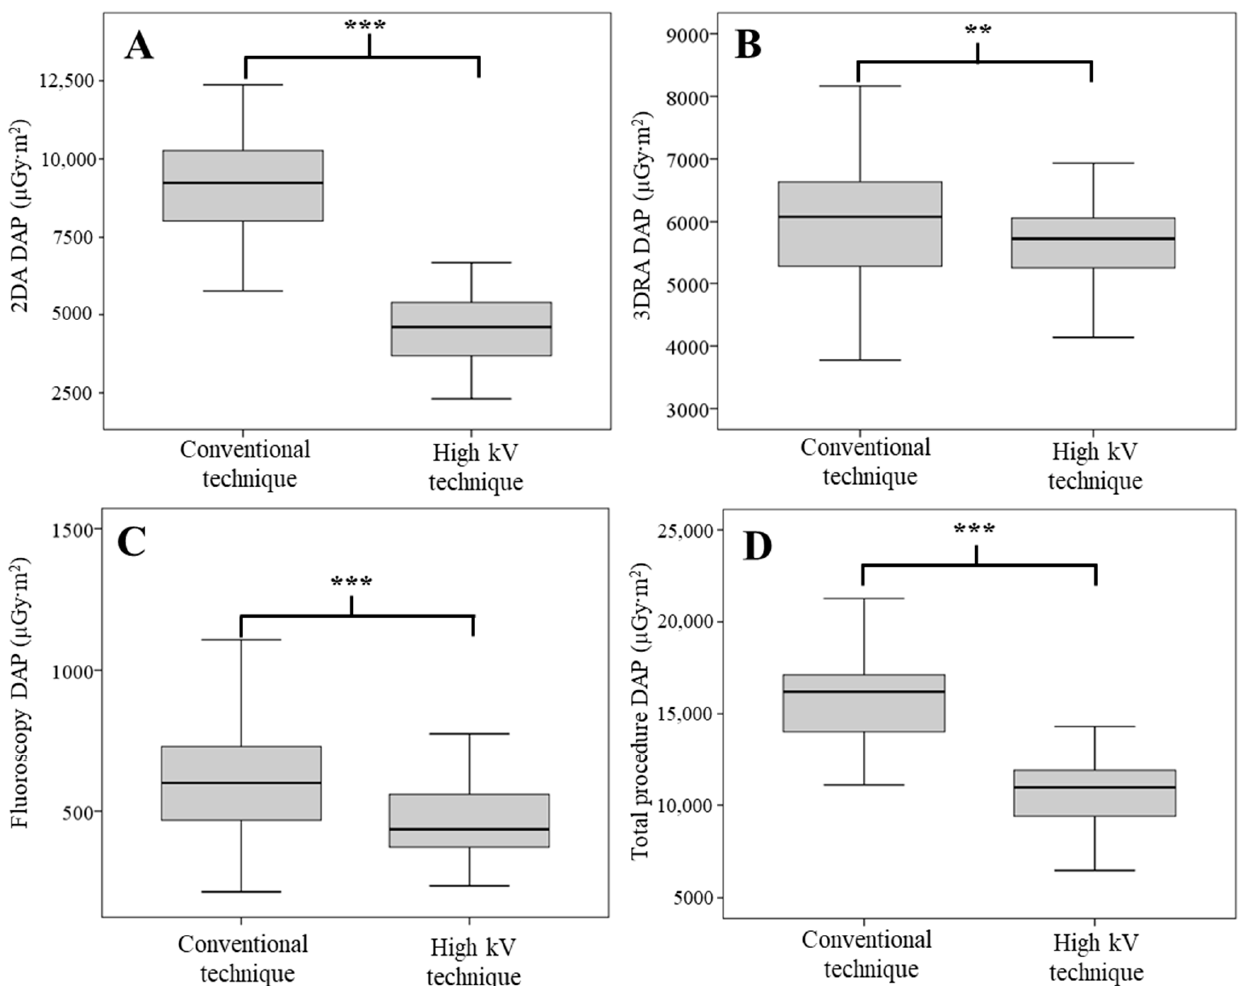
Figure 2. DAP from the 2DA technique ( A ), 3DRA technique ( B ), fluoroscopic technique ( C ), and total DAP ( D ). ** and *** indicate significant differences with p -value < 0.01 and 0.001, respectively.